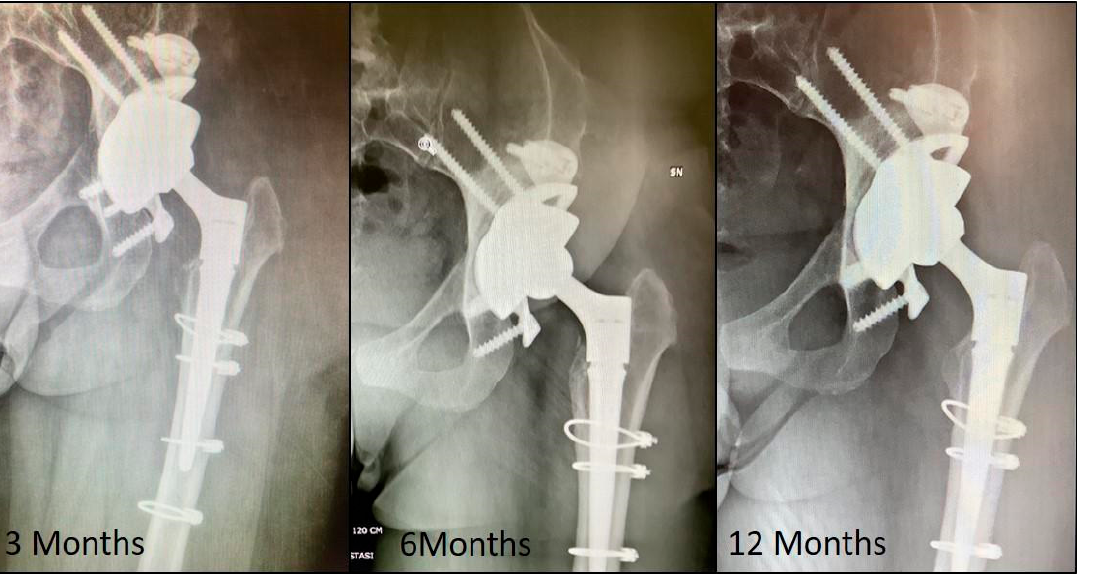
Figure 7. X-ray of the hip at 3, 6, and 12 months’ follow-up, showing a stable fixation of the implant over the time. over the